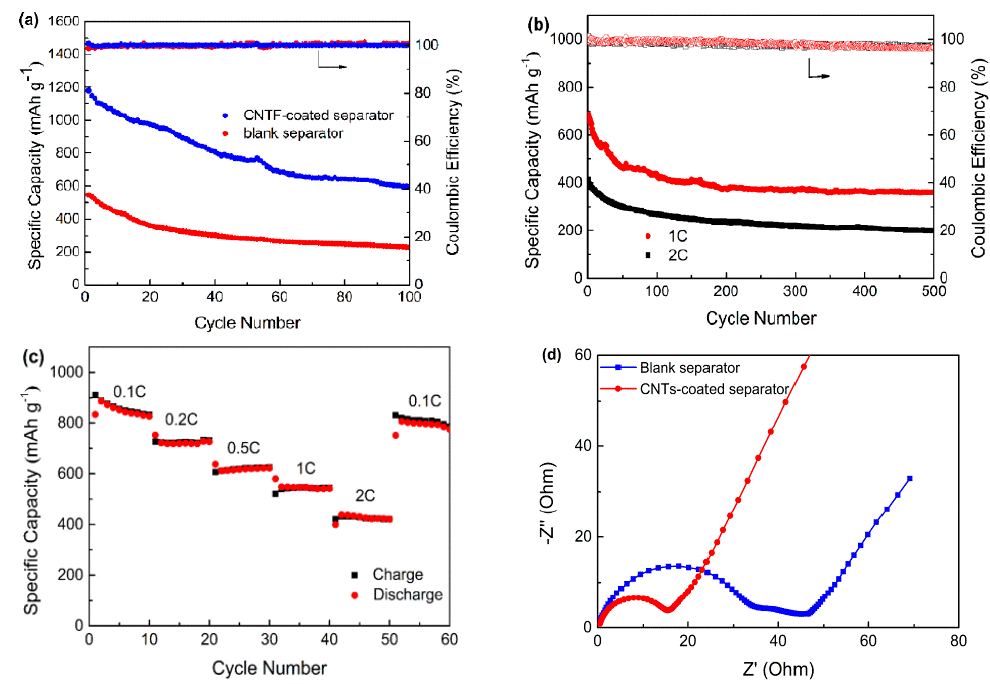
Figure 7. ( a ) Cycling performance of the blank separator and CNTs-coated separator at 0.1C; ( b ) Cycling performance of the CNTs-coated separator at the rates of 1C and 2C; ( c ) Rate performance of the Li-S batteries with the CNTs-coated separator; ( d ) EIS data of the cells with the blank separator and CNTs-coated